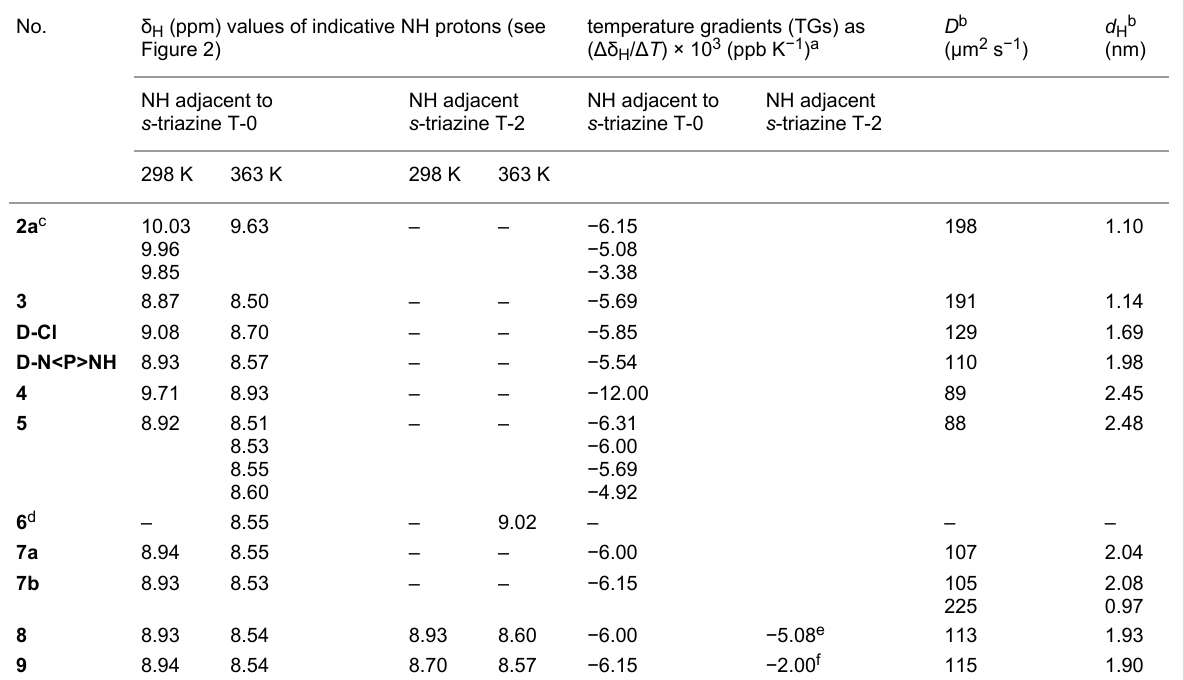
Table 3: Relevant (VT) 1 H NMR, temperature gradients and 2D- 1 H-DOSY NMR data (500 MHz, DMSO- d 6 ) of G-0 dendrons 2a , 3 , G-1 dendrons D-Cl , D-N<P>NH and G-2 dendrimers 4–6 , 7a , 7b , 8 , 9 . No.